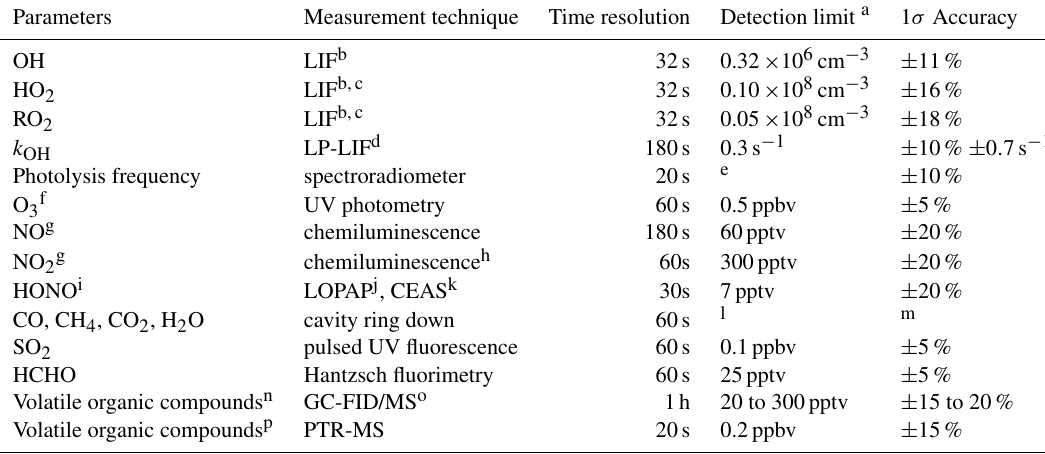
Table 1. Measured quantities used for data analysis and model calculations.